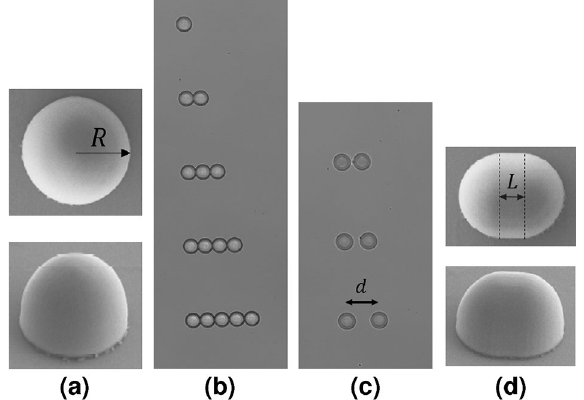
Figure 1. SEM- and microscope images of one of each of the configurations investigated by FTIR spectroscopy. ( a ) A single dome of radius R = 10 µ m , ( b ) touching domes in a row, ( c ) two domes with increasing distance d , and ( d ) semi-capsules (elongated domes) with a radius of the end-caps equal to R = 10 µ m and elongation L . The material of the samples is OrmoComp 24